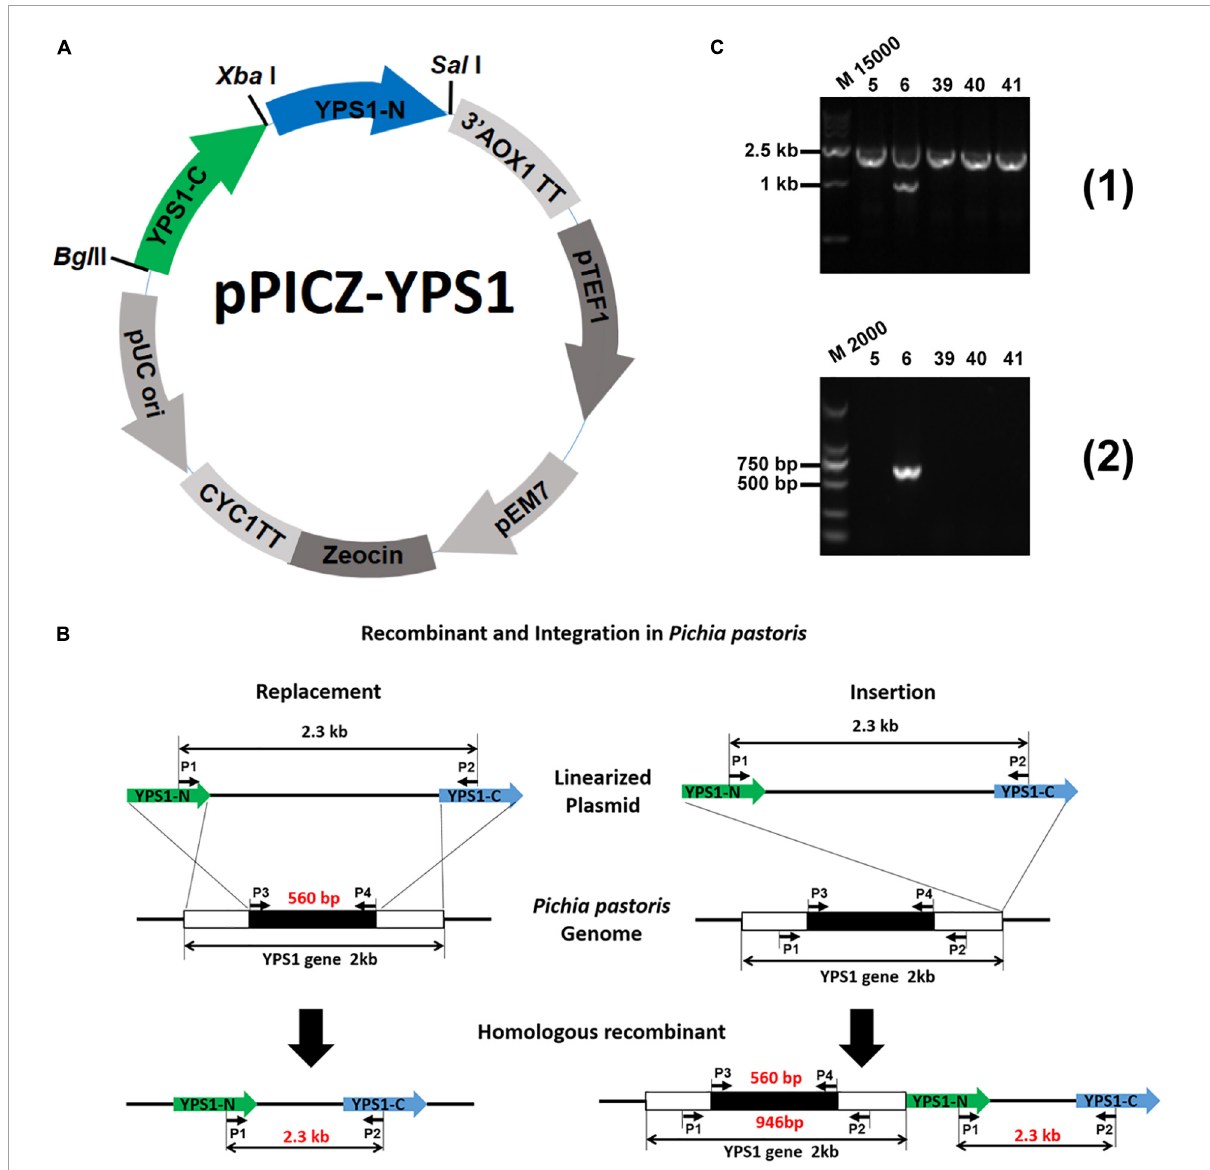
FIGURE1 Schematic representation of experimental procedures for YPS1 gene disruption and identification (Luo, 2019). (A) The map of the pPICZ-YPS1 plasmid was constructed in this study. (B) Homologous recombination and integration process of linearized pPICZ-YPS1. (C) The PCR products were amplified from the genome of transformants using the primer pairs P1 + P2 (1) and P3 + P4 (2). Lane M15000: DL15000 DNA Marker, lane M2000: DL2000 DNA Marker, lane 5, 6, 39, 40 and 41: Zeocin +